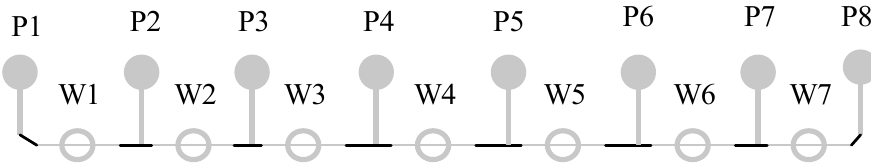
The distribution diagram of monitoring points on the experimental transmission line is shown in Figure 9.